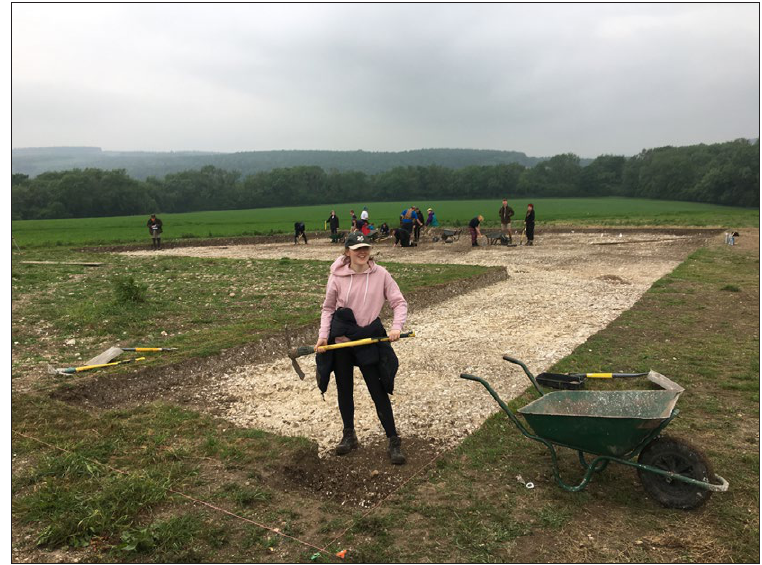
Figure 2: Current IoA Archaeology and Anthropology student Tarsha Coleman on excavation (Photo Tarsha